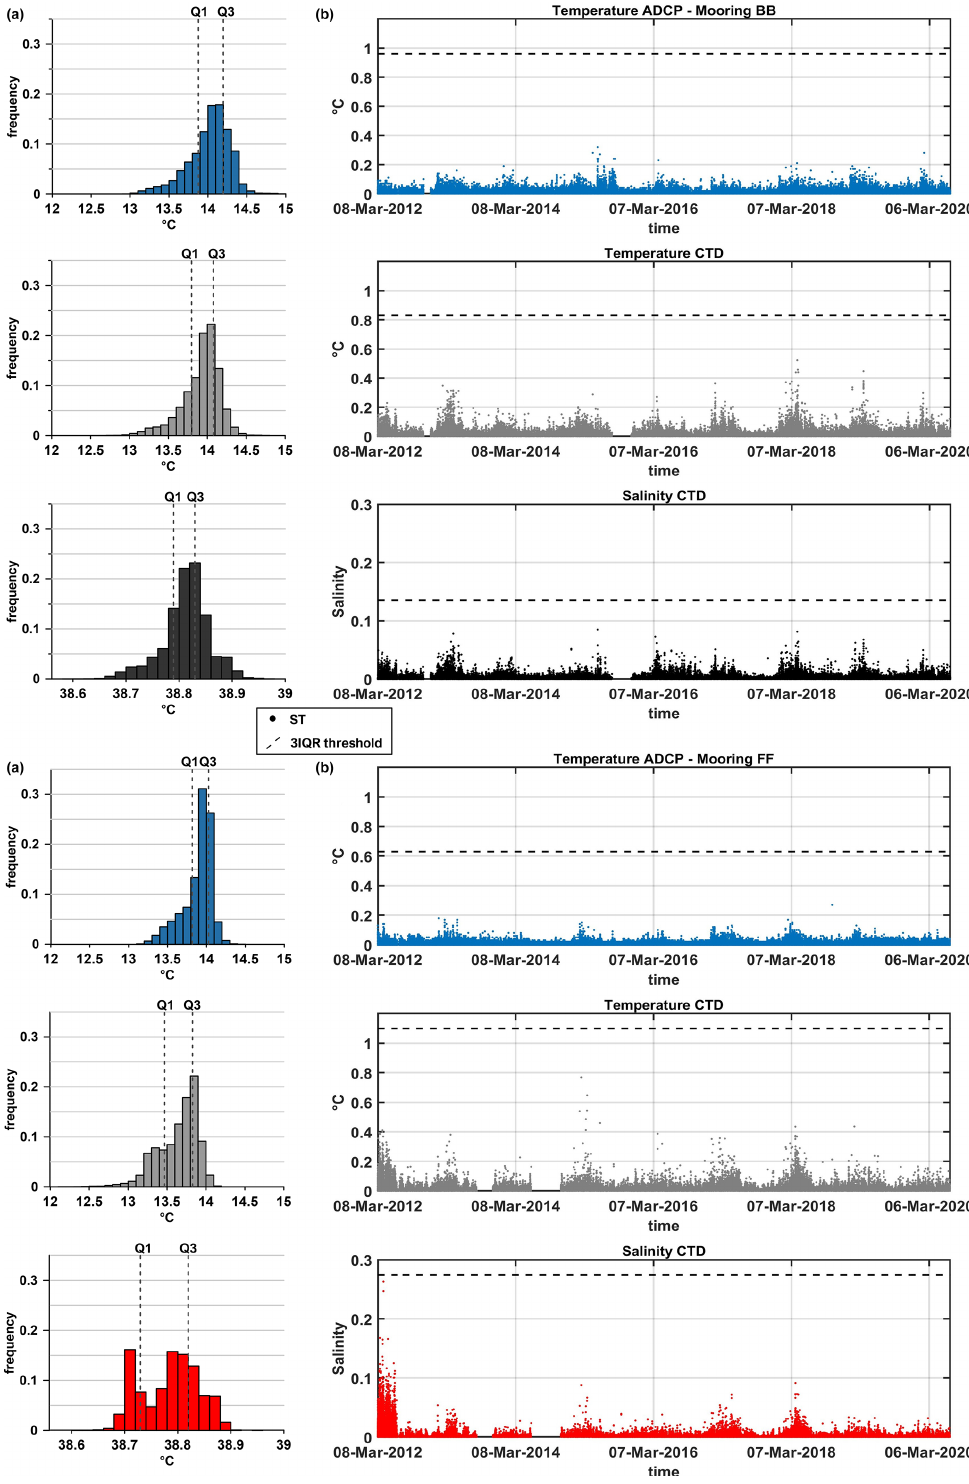
Figure 3. Quality control of temperature and salinity data measured by ADCP and CTD. (a) The distributions of the temperature and salinity data recorded at each berth are shown, and Q1 and Q3 represent the 25th and 75th percentiles used for IQR calculation. (b) The time series of the ST value calculated for each observation (dots) and the 3IQR value (dashed line) indicating the threshold for identifying outliers are